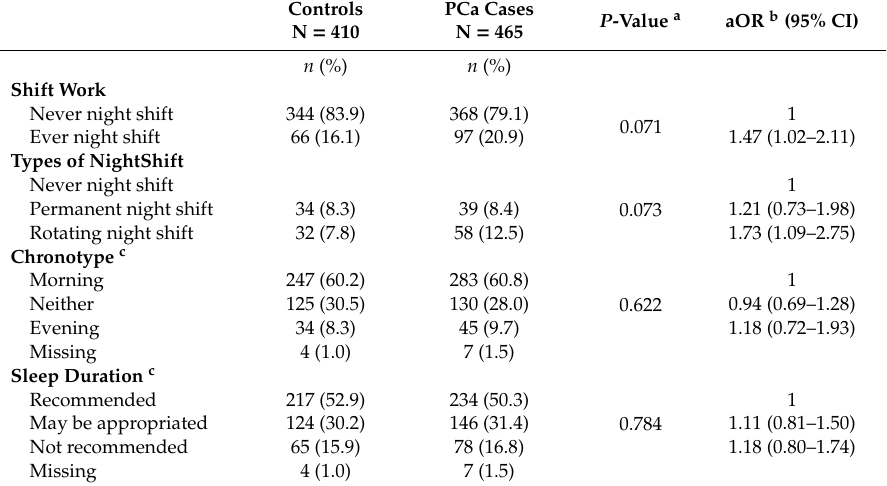
Table 2. Associations between PCa and night shift work, chronotype, and sleep duration.